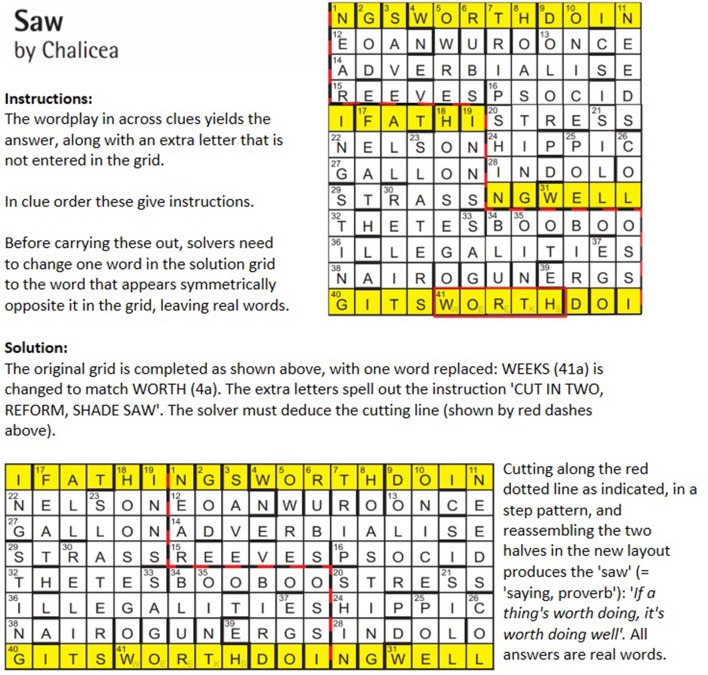
Magpie crossword issue 166.1 (Chalicea, 2016).